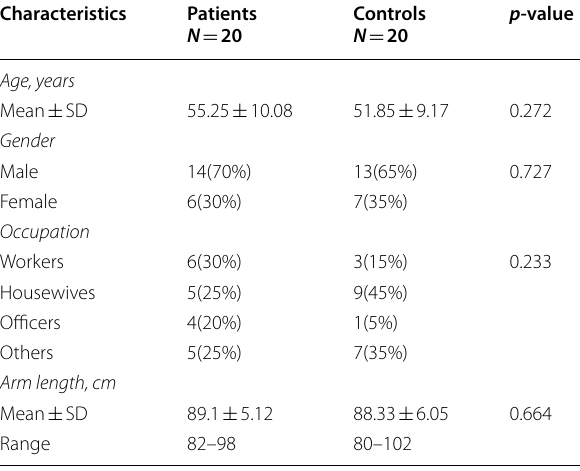
Table 1 Demographic data of the study